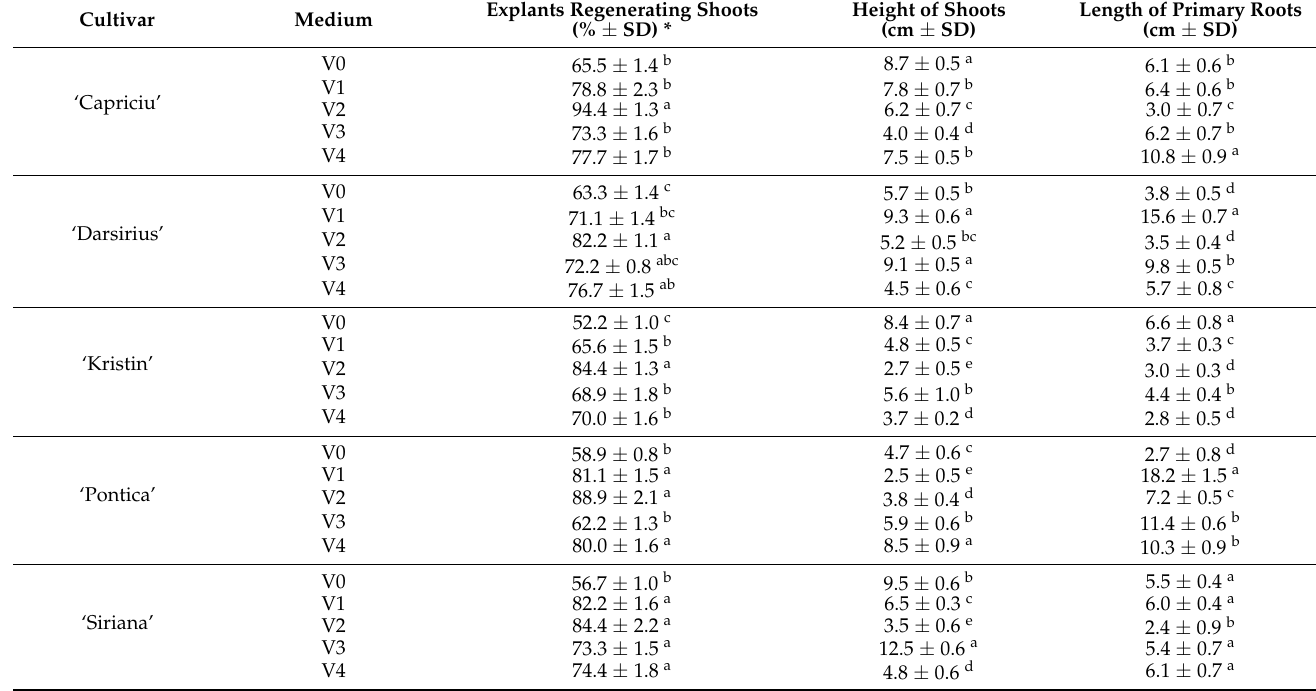
Table 3. Direct shoot organogenesis from stem nodes on culture media with different cytokinins.